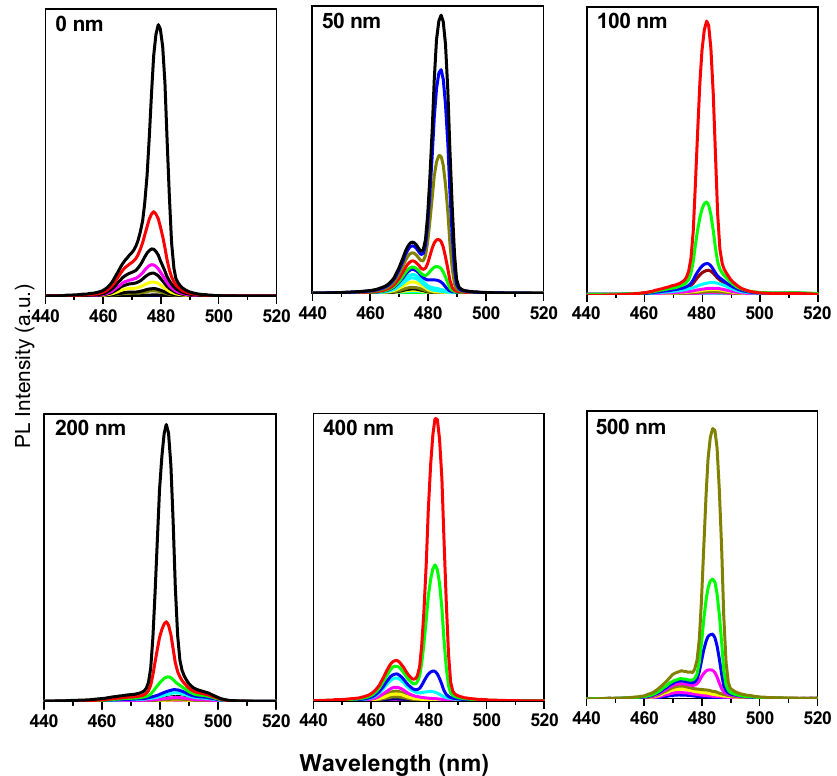
Figure 8. Pump-fluence relationship for CsPb(Br 0.5 Cl 0.5 ) 3 thin films, bare and with various thicknesses of polymethyl methacrylate (PMMA) polymer coating as a passivation layer.